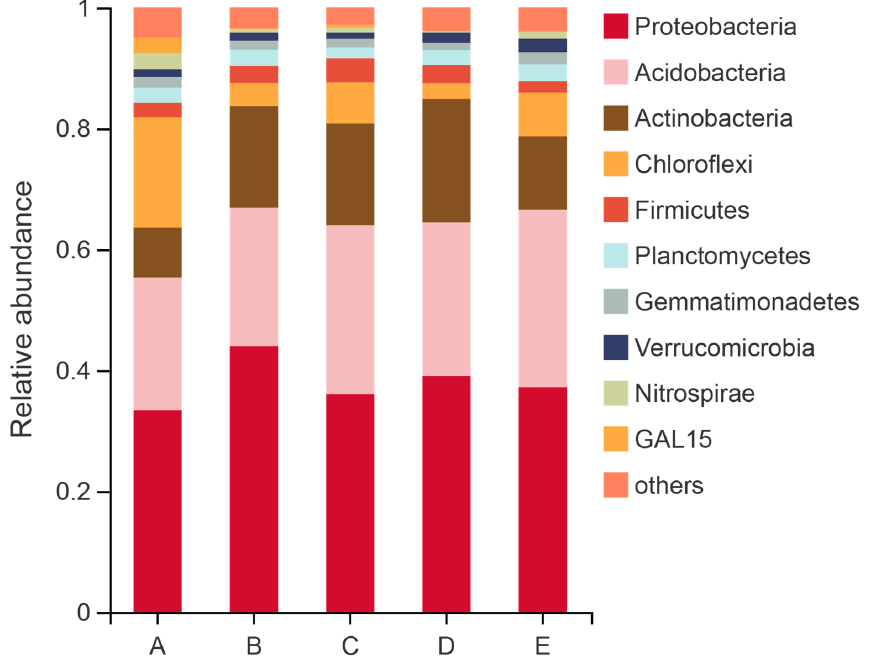
Figure 2. Bacterial community composition at the phylum level. A, C. kerrii forest; B, the lower range limit of C. pingbianense forest; C, the range center of C. pingbianense forest; D, the upper range limit of C. pingbianense forest; E, L. glaber forest. Table 2. Bacterial phyla and genera with significant difference among five sites.